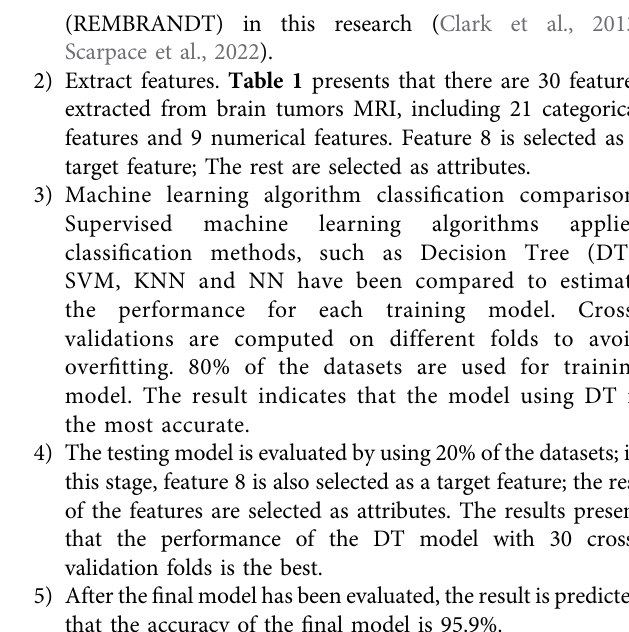
Frontiers in Pharmacology |